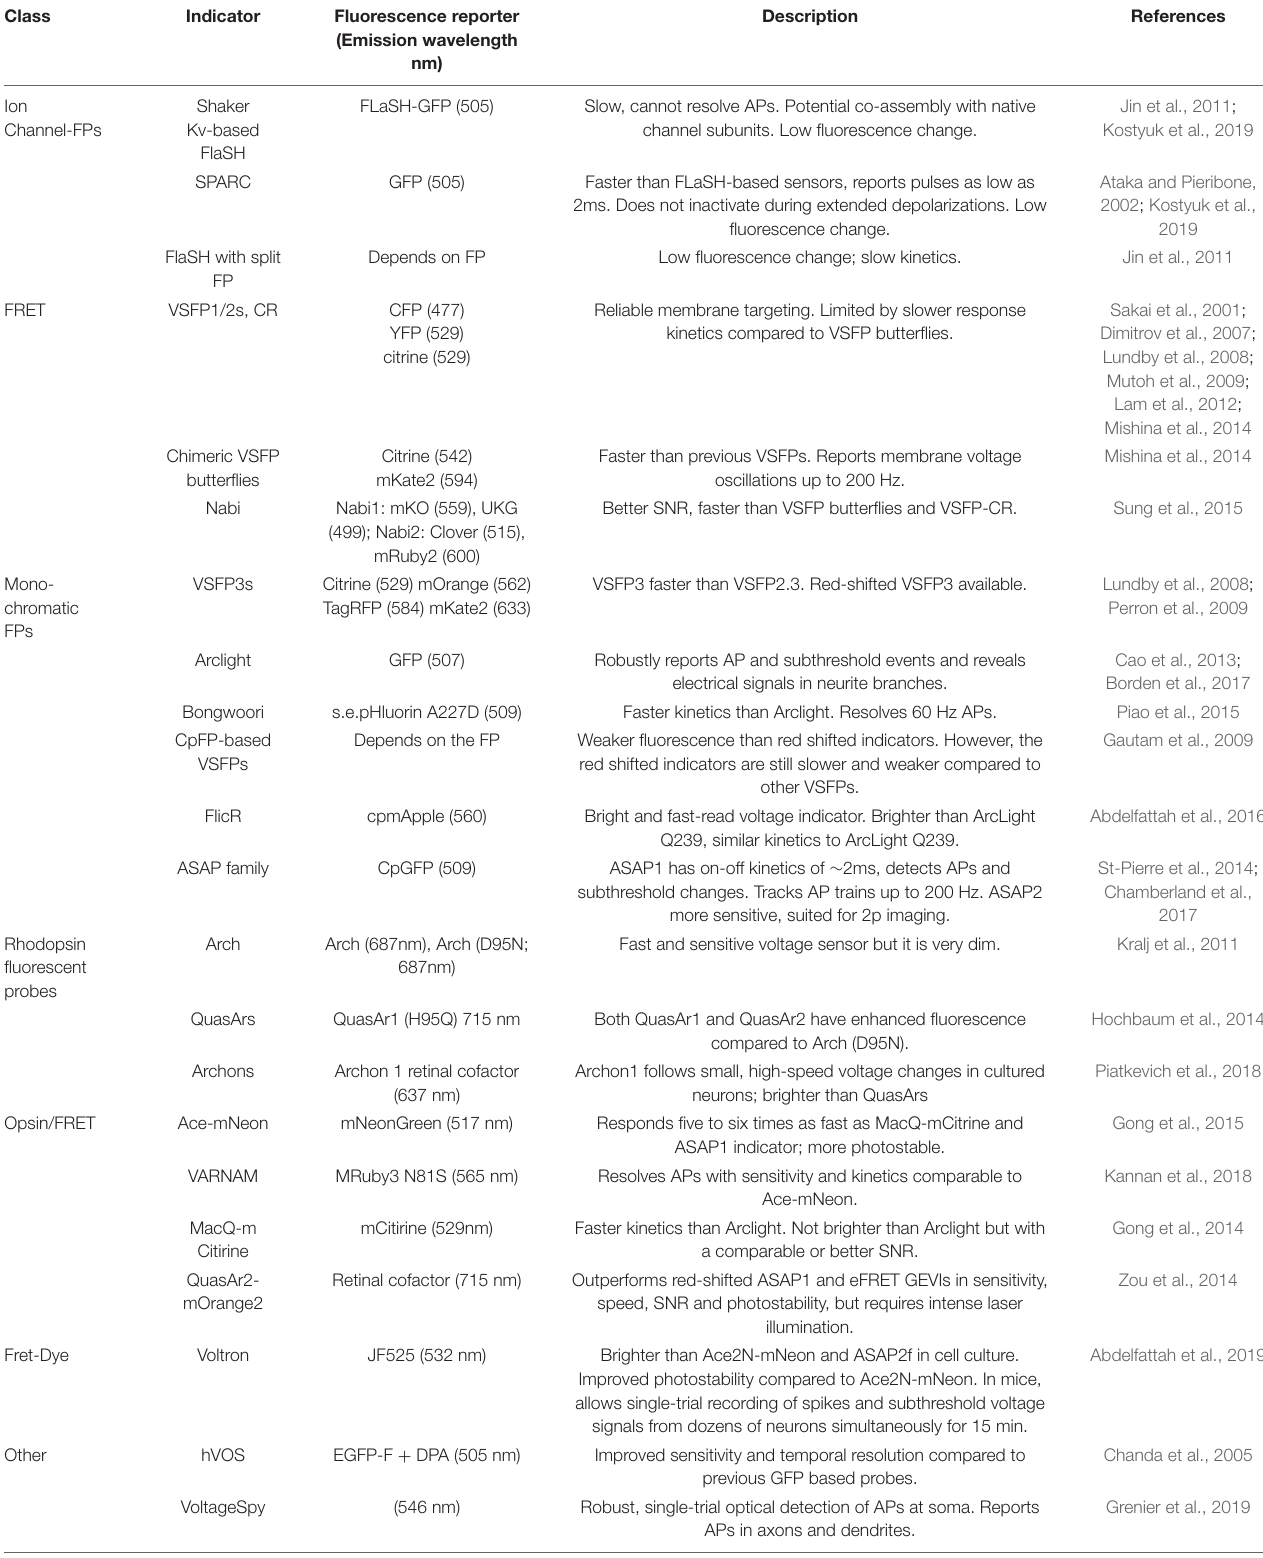
TABLE 4 | Commonly used